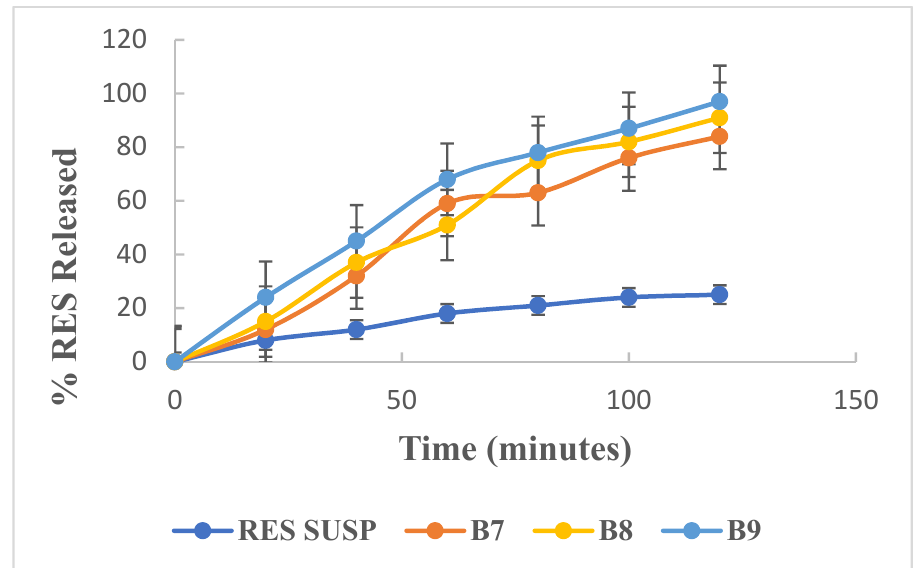
Figure 2. In vitro release study of resveratrol from different formulations in phosphate buffer saline pH (7.4) using the dialysis bag method. 3.3. TEM